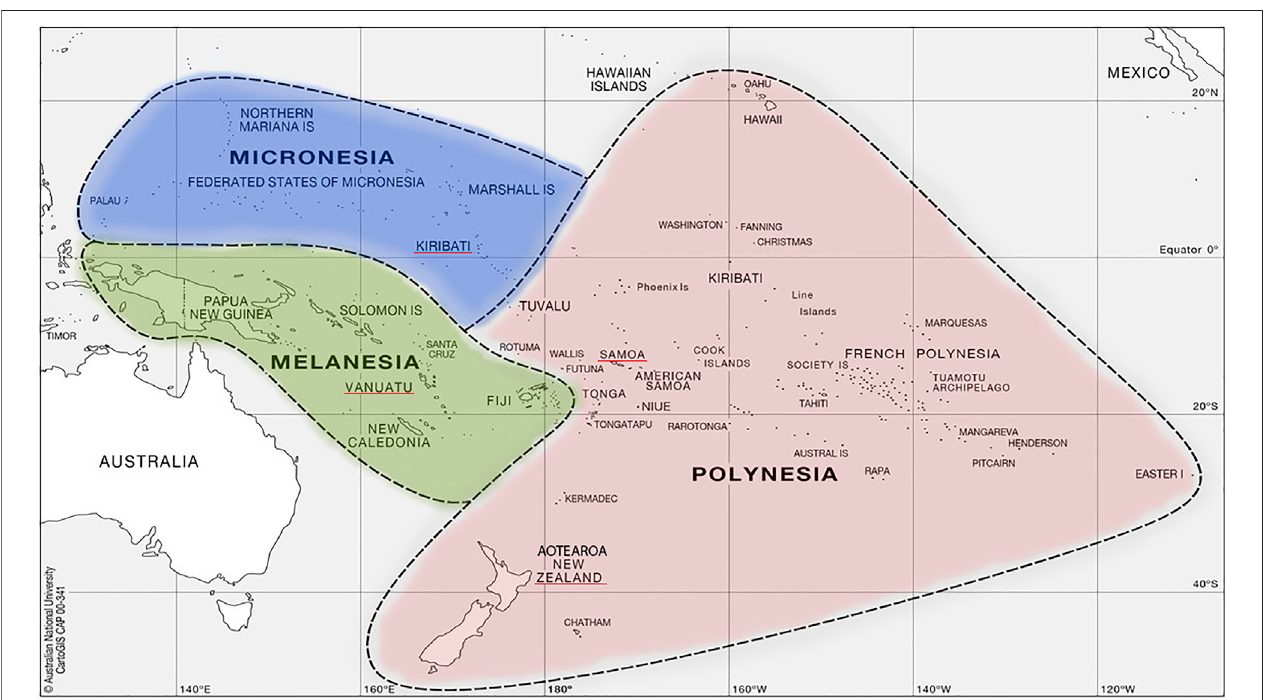
FIGURE 1 | Regions of Oceania. Source: Adapted from Australian National University (CC Licence).